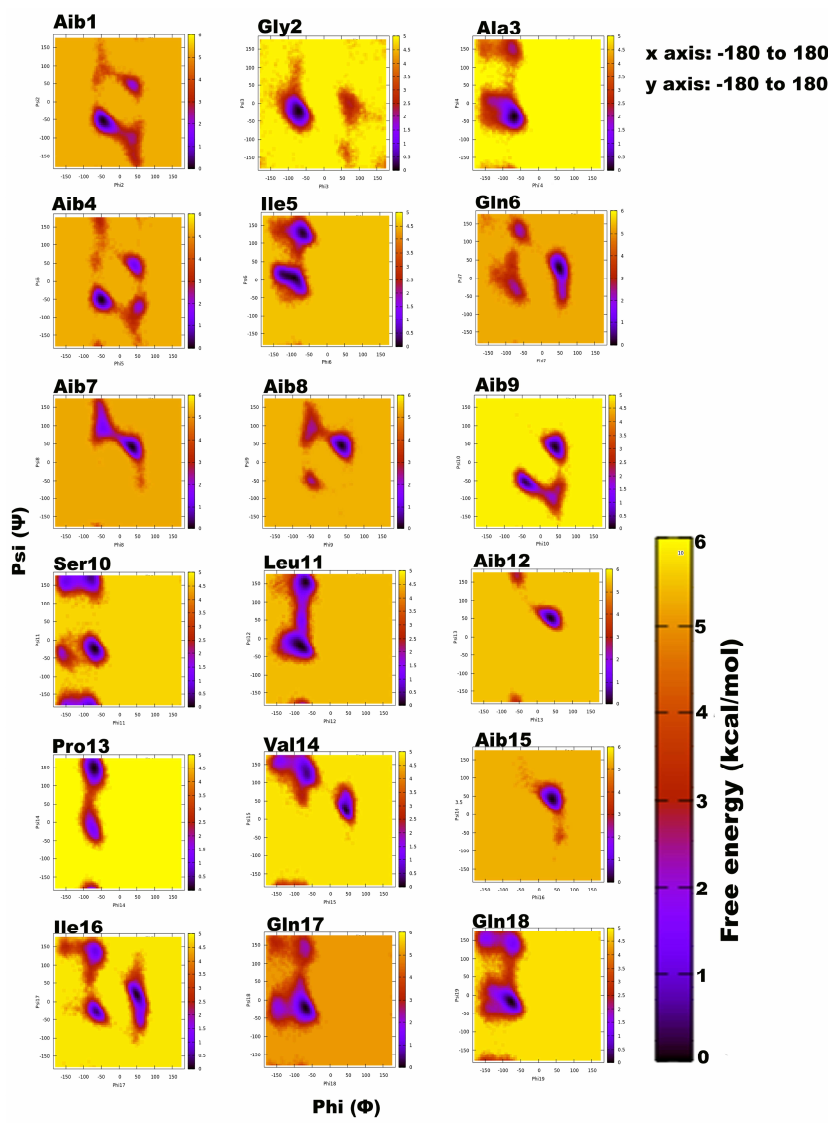
Figure 1. Free energy-based Ramachandran plots for each Trikoningin KA V residue during 100 ns long implicit water simulation. The x and y axes range from − 180 to +180. The darkest red regions indicate toward minimum energy secondary structural regions favoured by each residue during the simulation.